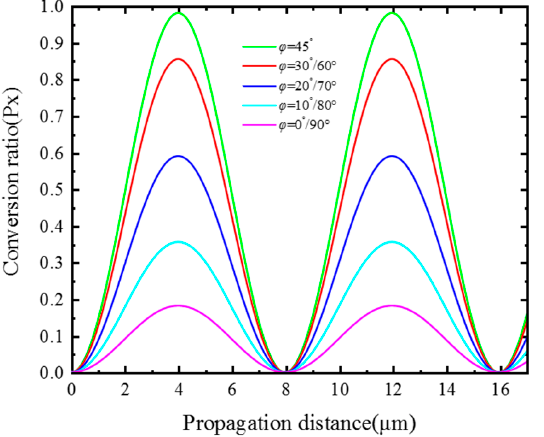
Figure 5. The conversion ratio changes with the propagation distance under different liquid crystal rotation angles.